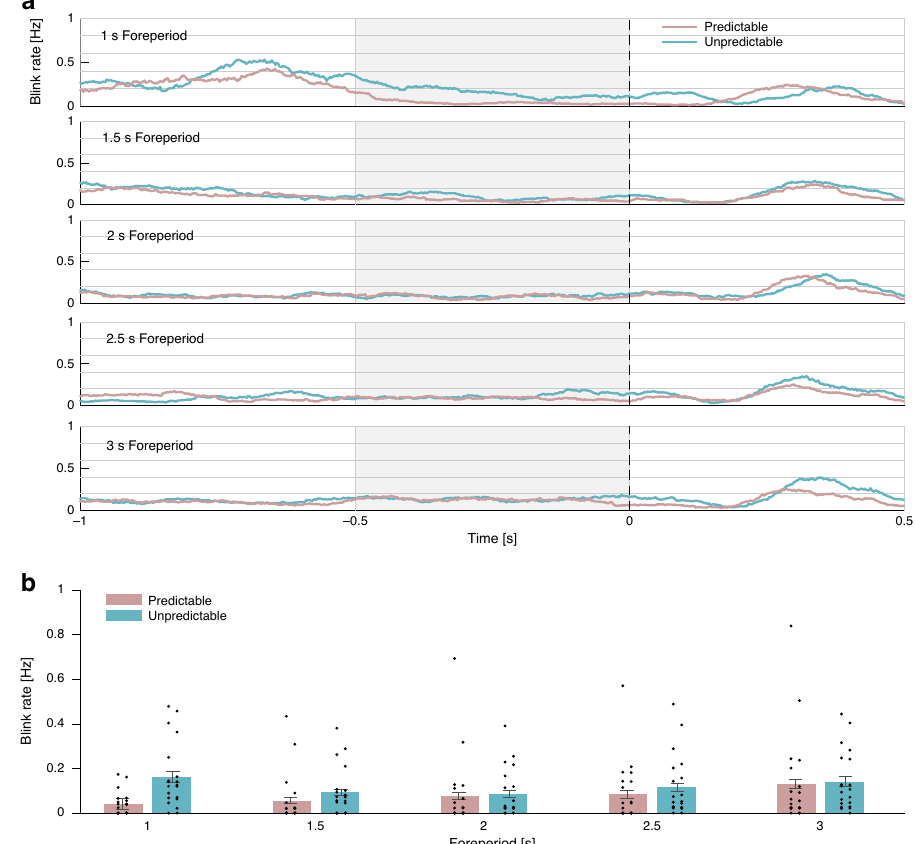
Fig. 5 Blink rates by predictability and foreperiod. a Grand average ( N = 20) blink rate traces in the predictable (pink) and unpredictable (turquoise) conditions in each foreperiod duration, smoothed with a sliding window of 100 ms. The light gray rectangles mark the analysis window. The dashed line represents target onset. b Grand average pretarget blink rate in the predictable (pink bars) and unpredictable (turquoise bars) conditions at − 500 to 0 ms relative to target onset. Error bars denote ±1 standard error of the mean, corrected for within-subjects variability 60 . N = 20 participants. Source data are provided as a Source Data fi